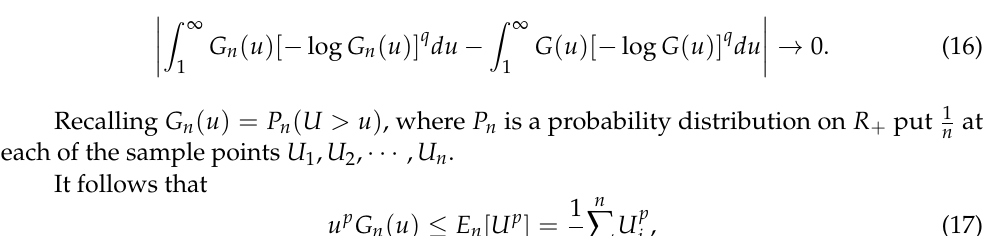
Figure 5. The fractional cumulative residual entropy of exponential distribution with λ = 0.5 and exponential distribution λ = E